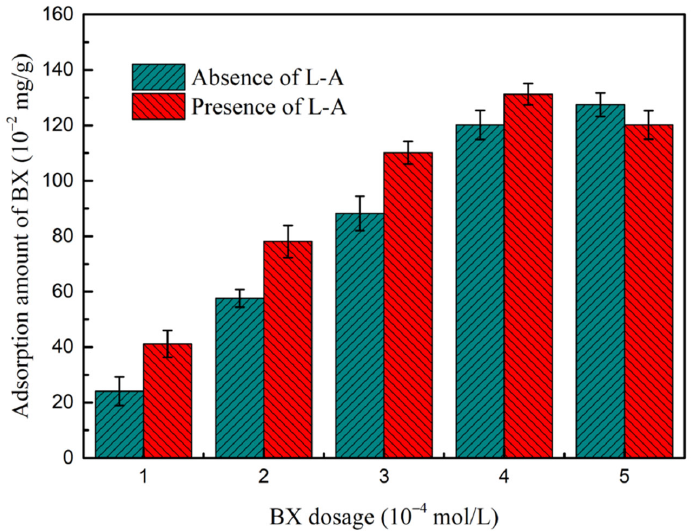
Figure 7. The adsorption amount of BX in the solution as a function of BX dosage in the absence and presence of LA ( c (LA) = 6.0 × 10 − 5 mol/L; c (Na 2 S) = 3.0 × 10 − 3 mol/L; pH = 9).